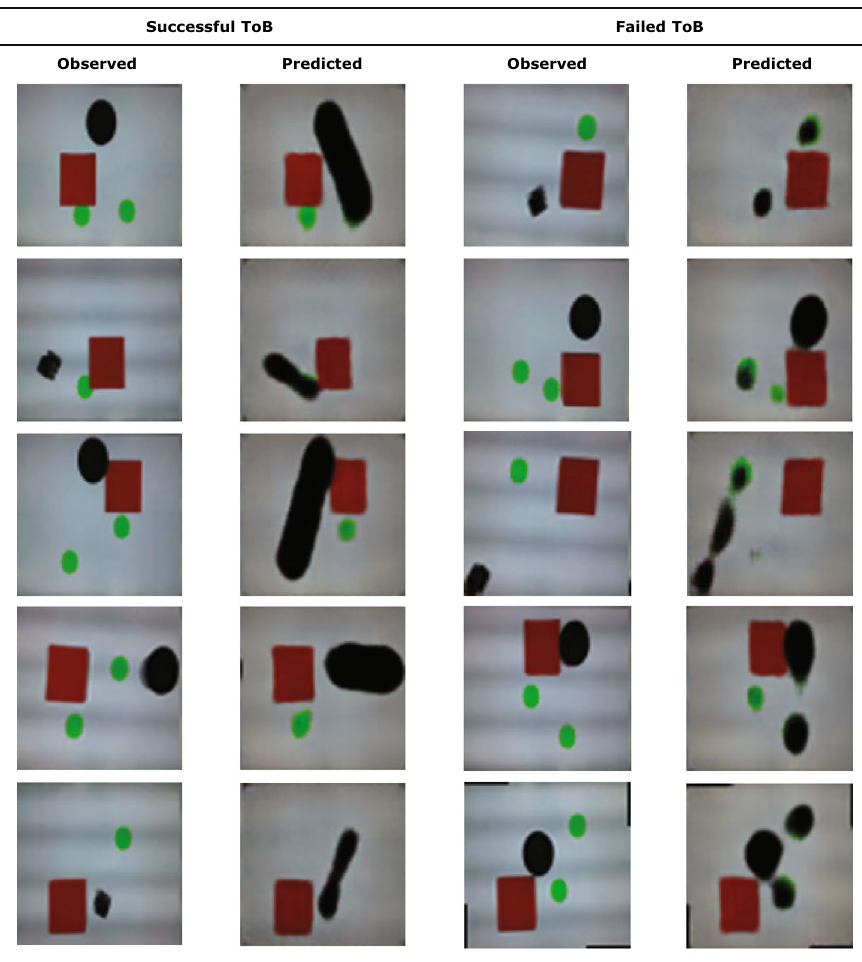
Figure 6. Physical scenes and outcomes envisioned by the observer. The first column and the third column show some sample scenarios involving the actor robot, one or two green foods, and a square obstacle. The second and the fourth column show the outcome as envisioned by the observer. The left two columns (Success) show successful vision, whereas the right two columns (Failure) show failed or blurry